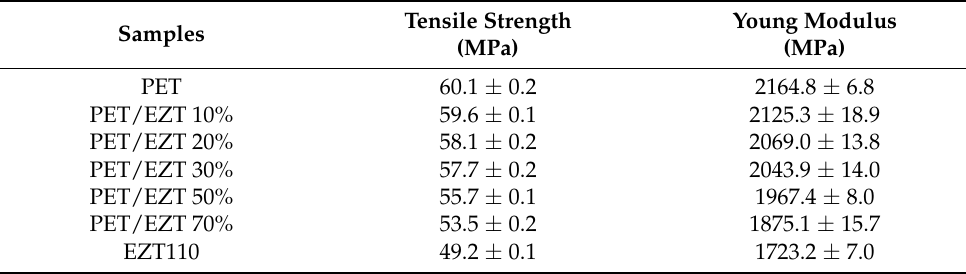
Table 3. Tensile strength and Young’s modulus of the PET/EZT samples.